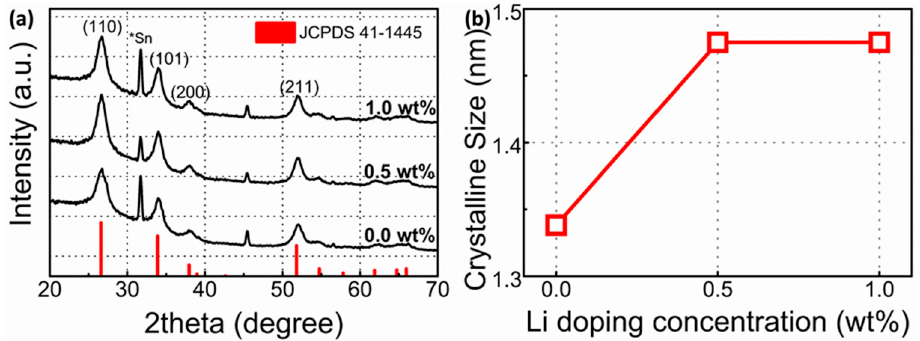
Figure 1. ( a ) The Grazing Incidence X-ray Diffraction spectra of SnO 2 films and ( b ) calculated crystalline sizes of SnO 2 films as a function of Li (wt%).